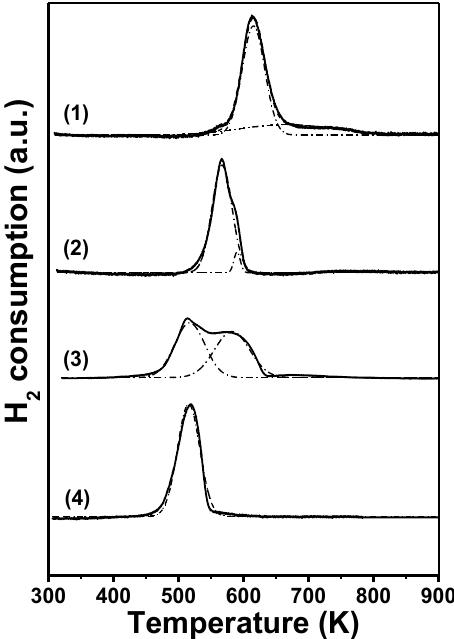
Figure 3. TPR profiles of calcined oxide precursors prepared in this work (H 2 (5%)/Ar; 60 cm 3 .min − 1 ; 10 K.min − 1 ): (1) Cu/SiO 2 -I, (2) Cu/SiO 2 -PD, (3) Cu/Al 2 O 3 -I, (4) CuMgAl.